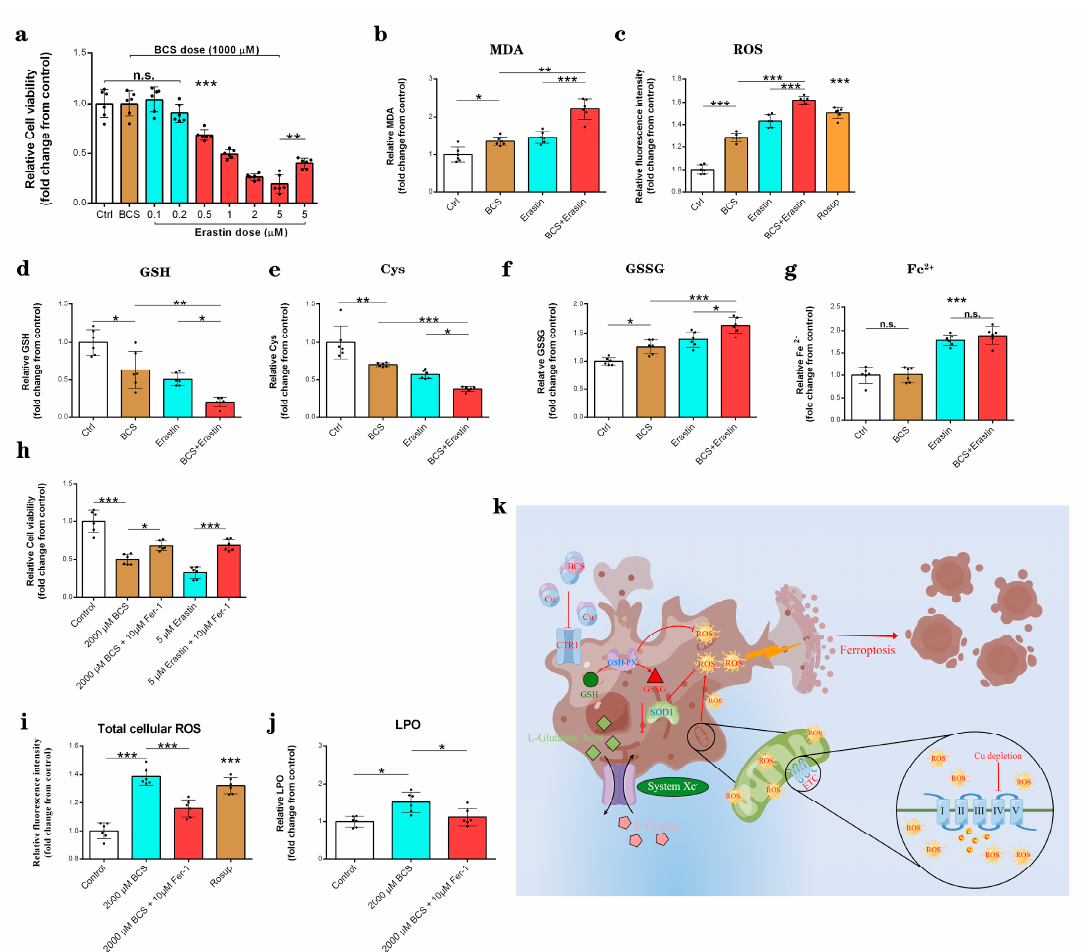
Figure 6. ( a ) A cell counting kit-8 (CCK-8) assay was used to assess the effect of the combination of BCS (1000 µ M) and erastin (0.1~5 µ M) on DPC viability after 48 h of treatment ( n = 6/group). n.s. no significance; ** p < 0.01; *** p < 0.001. ( b - g ) Measurement of MDA, total of cellular ROS, GSH, cysteine, GSSG, and Fe 2+ , contents in dermal papilla cells (DPCs) after 48 h of treatment with BCS (1000 µ M) and erastin (1 µ M) ( n = 6/group). n.s. no significance; * p < 0.05; ** p < 0.01; *** p < 0.001. ( h ) Effect of BCS (2000 µ M) and the ferroptosis inhibitor Fer-1 (10 µ M), the ferroptosis activator erastin (5 µ M), and Fer-1 (10 µ M) on cell death ( n = 6/group). * p < 0.05; *** p < 0.001. ( i - j ) Measurement of total cellular ROS and LPO contents in DPCs after 48 h of treatment with BCS (2000 µ M) and Fer-1 (10 µ M) ( n = 6/group). * p < 0.05; *** p < 0.001. ( k ) Model depicting the mechanism of ferroptosis induced by copper